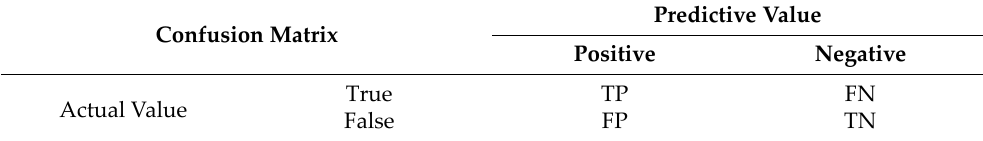
Table 5. Classification results.